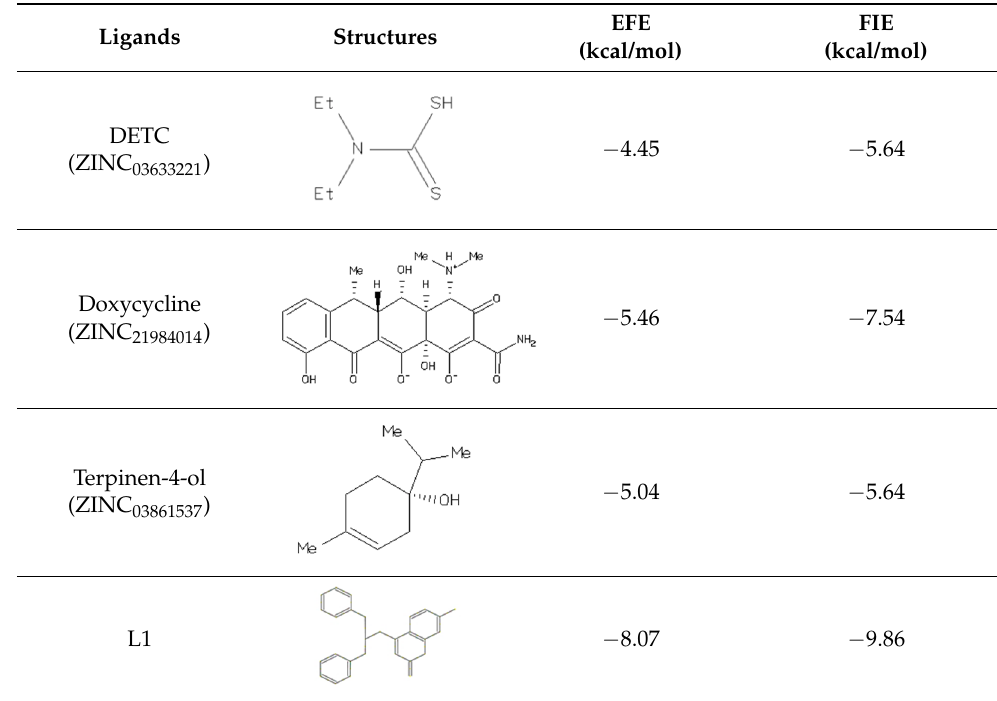
Table 1. Analyzed compounds in this study were labeled with Arabic numerals (Zinc database structures), and their structure shown. The highest score estimated the binding free energy (EFE) and the final intermolecular energy (FIE) based on docking of the crystal structure of the glycoprotein (gp63) with ligands, and are shown in the table. AutoDock4 estimates the ligand interactions of the docked complexes with the least global energy.